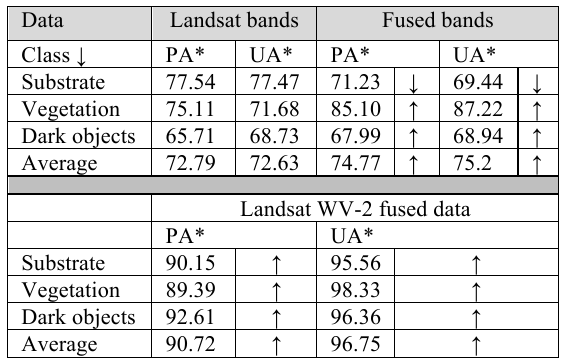
Table 2. Accuracy assessment for the classified Landsat data, classified WV-2 data and classified fused